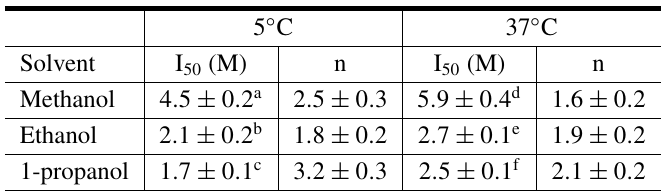
I 50 and cooperativity index, n, for the inactivation of yeast inorganic pyrophosphatase by alcohols.